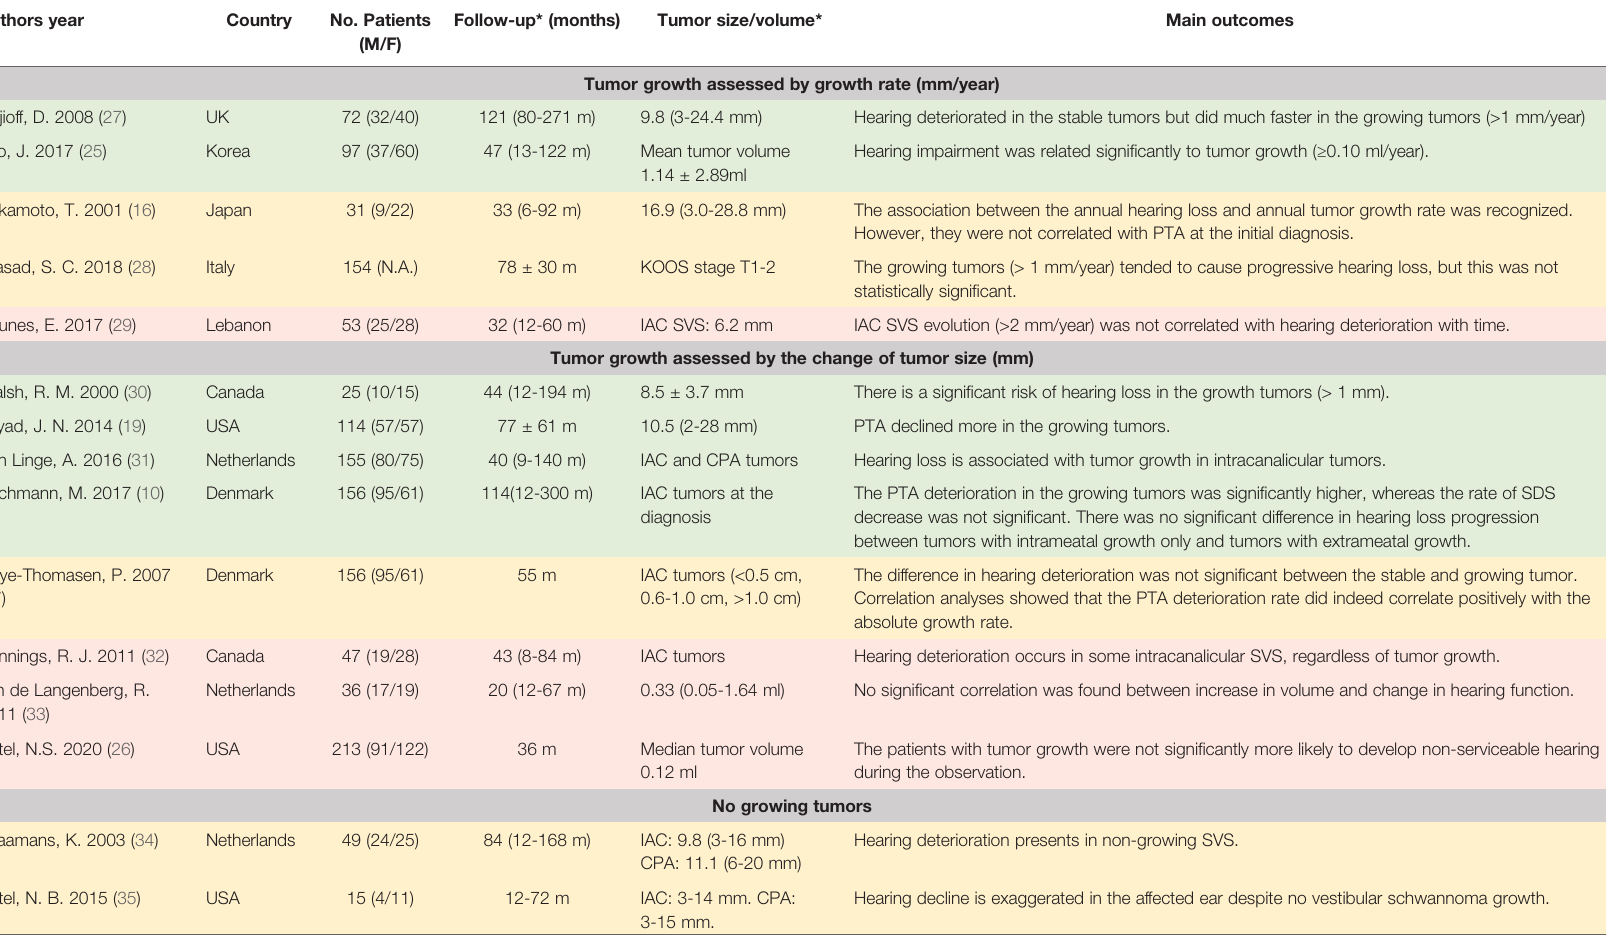
TABLE 2 | The summarization of literature regarding the association between tumor growth rate and hearing